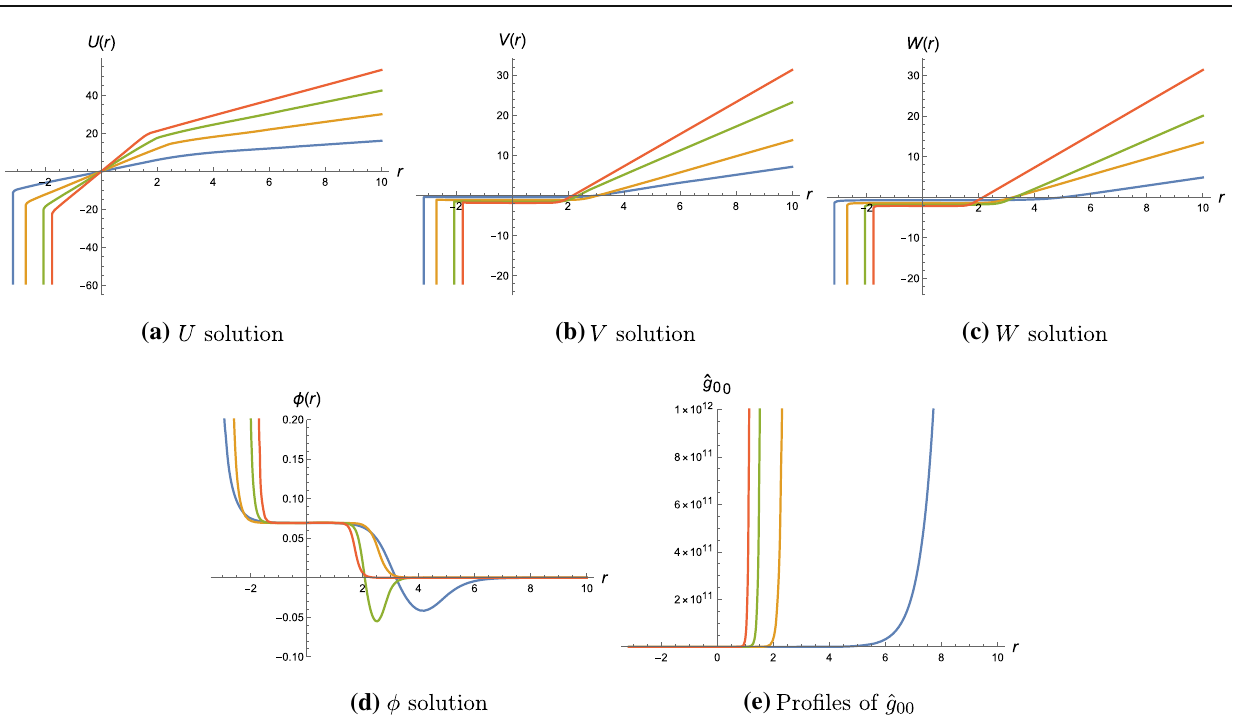
Fig. 30 RG flows from supersymmetric AdS 7 vacuum to the AdS 2 × H 3 × H 2 fixed point and curved domain walls with SO ( 3 ) × SO ( 2 ) twist in SO ( 5 ) gauge group. The blue, orange, green and red curves refer to g = 8 , 16 , 24 , 32,